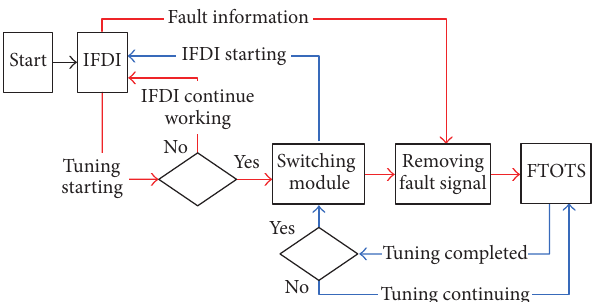
Figure 2: The channel switching process of a fault-tolerant OBEM tuning